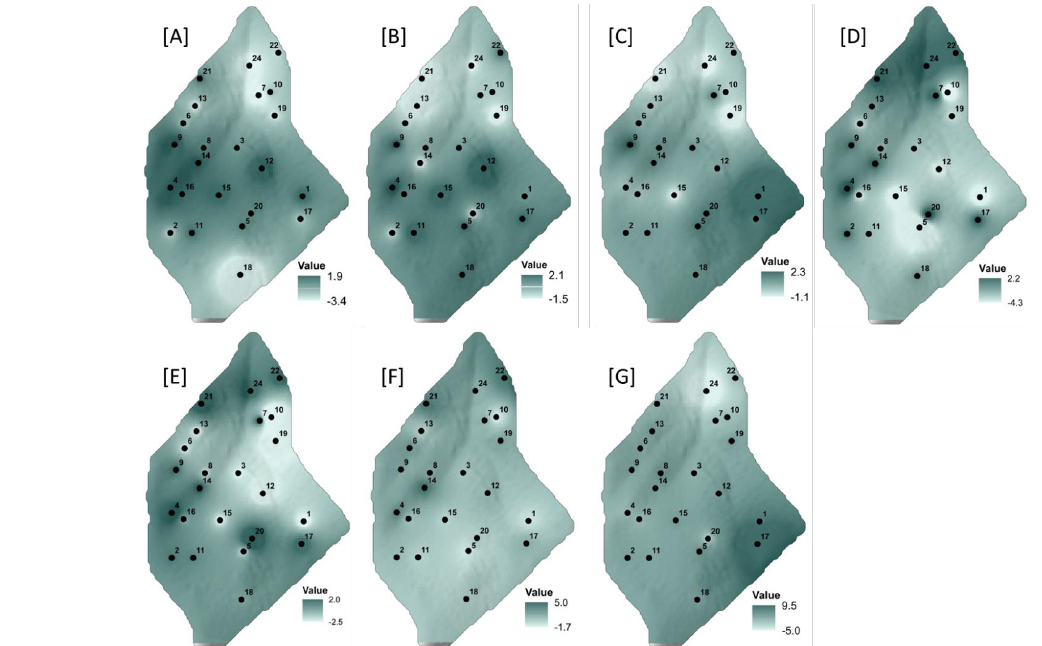
Figure 5. Spatially interpolated logit-transformed regression model residuals for (a) clay percent, (b) KCl pH, (c) τ Na , (d) soil depth, (e) clay stocks, (f) carbon stocks, and (g) Na mass flux. Residuals were interpolated using an optimized inverse distance weighting.